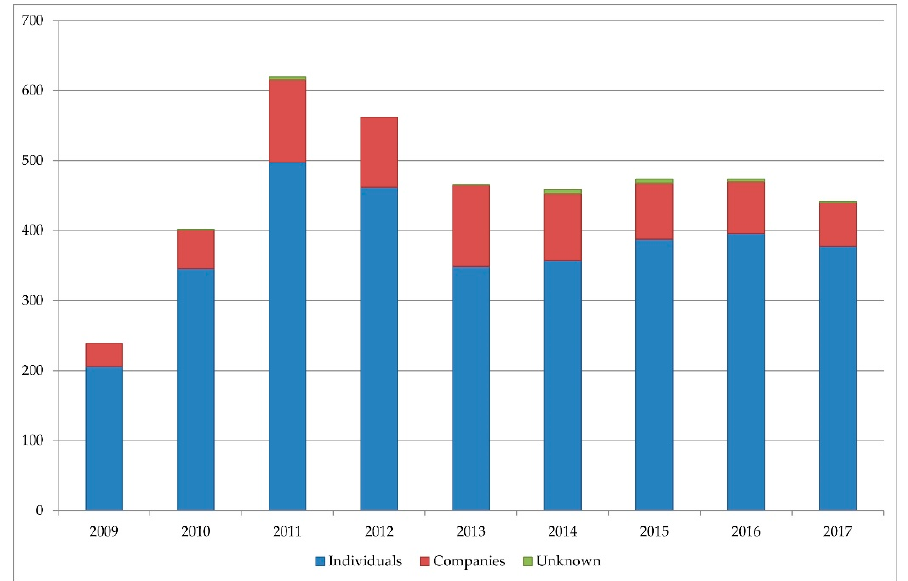
Figure 3. Number of Positive Judicial Actions of the Common Service of Las Palmas de Gran Canaria by category of the party involved and year. Data: Common Service of Notifications and Liens of the Judicial District for Las Palmas de Gran Canaria. Own production.